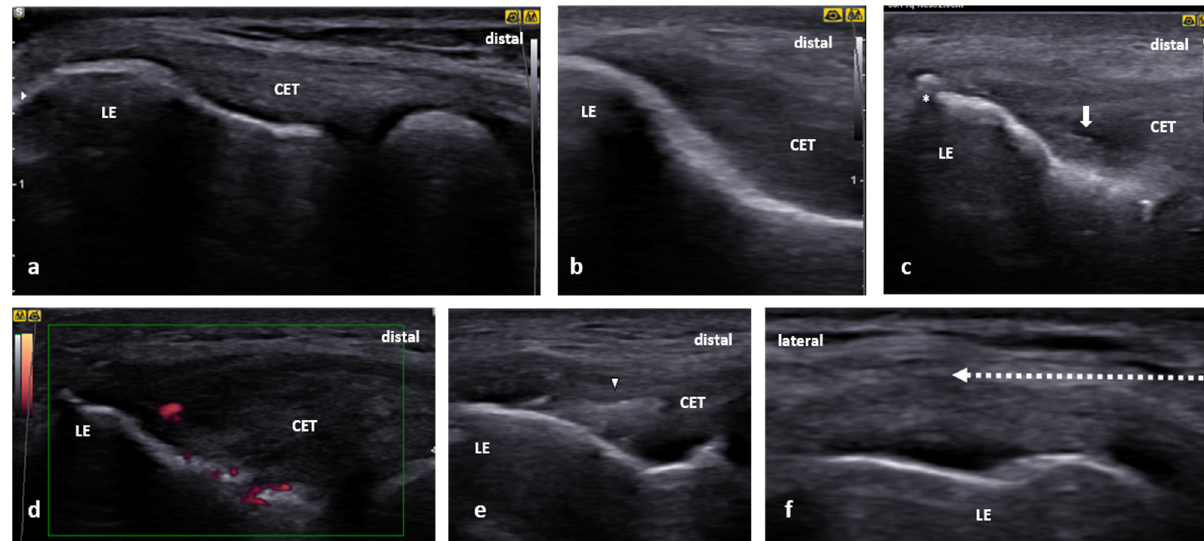
Figure 4. Ultrasound (US) images of the CET: ( a ) normal image, ( b ) a simple thickening and hypoechogenicity of the CET, ( c ) US image demonstrating a prominent spur (white asterisk) on the tip of the lateral epicondyle (LE) and focal hypoechogenicity in the tendon (white arrow), ( d ) a severe swelling of the CET with increased vascularity on power Doppler, ( e ) a mild swelling of the CET with intrasubstance hyperechogenicity indicating an immature calcification (white arrowhead) without acoustic shadowing, and ( f ) a US-guided peritendinous CET injection showing the needle (white, dotted arrow) being inserted from medial to lateral in a short axis of the CET.